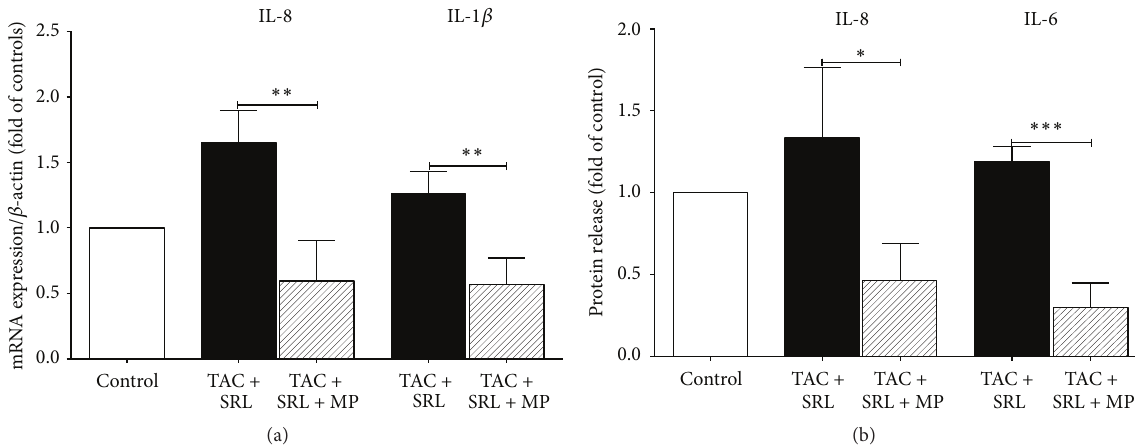
Figure 4: The effect of methylprednisolone on the inflammatory potential in human islets. Human islets cultured with tacrolimus (TAC 30 𝜇 g/L), sirolimus (SRL 30 𝜇 g/L), with or without methylprednisolone (MP 1000 ng/L), for 24 hours were tested for (a) gene expression of IL-1beta and IL-8 and (b) protein release of IL-8 and IL-6. The fold change represents the expression of target genes in isolated islets relative to the 𝛽 -actin mRNA level. Data is presented as mean ± SEM of four separate experiments from four different donors. ∗ 𝑝 < 0.05 , ∗∗ 𝑝 < 0.005 , and ∗∗∗ 𝑝 < 0.0005 versus